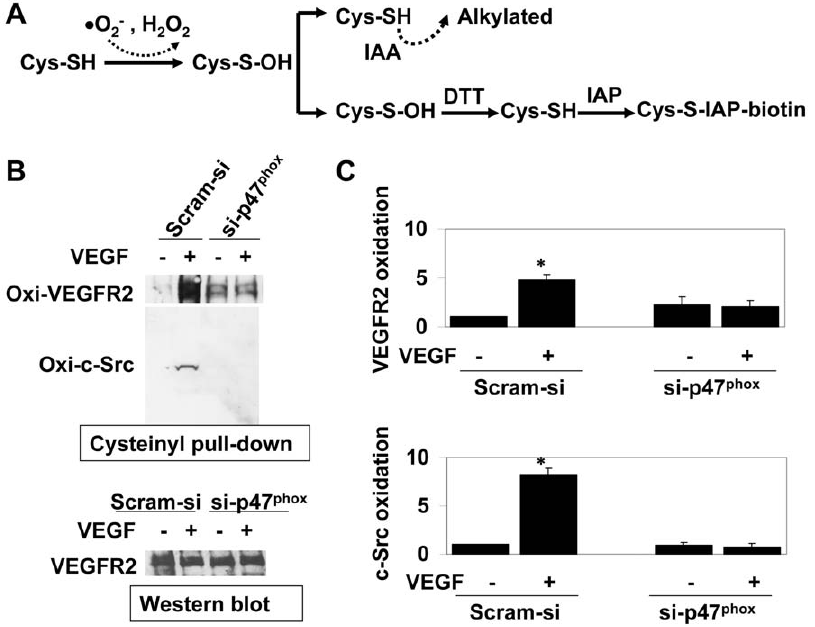
Figure 2. c-Src and VEGFR-2 are oxidized in VEGF-treated HCAEC in the presence of NADPH oxidase-derived ROS. (A) Schematic presentation depicting cysteinyl-labeling assay to determine oxidative modification in intracellular proteins. Non-oxidized protein thiols are treated (50 ng/ml for 2 mins) HCAEC lysates using biotinylated IAP probe. HCAEC were transfected with Scram-si or si-p47 phox as indicated. After cell lysis in the presence of IAA followed by DTT treatment and IAP labeling, 1.5 mg biotinylated protein lysates were subject to immunoprecipitation